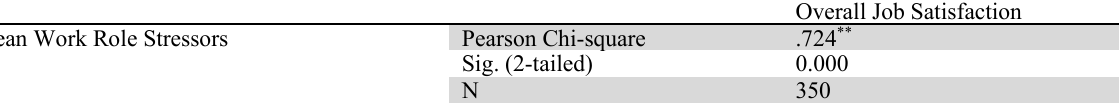
Chi-square tests Work Role Stressors